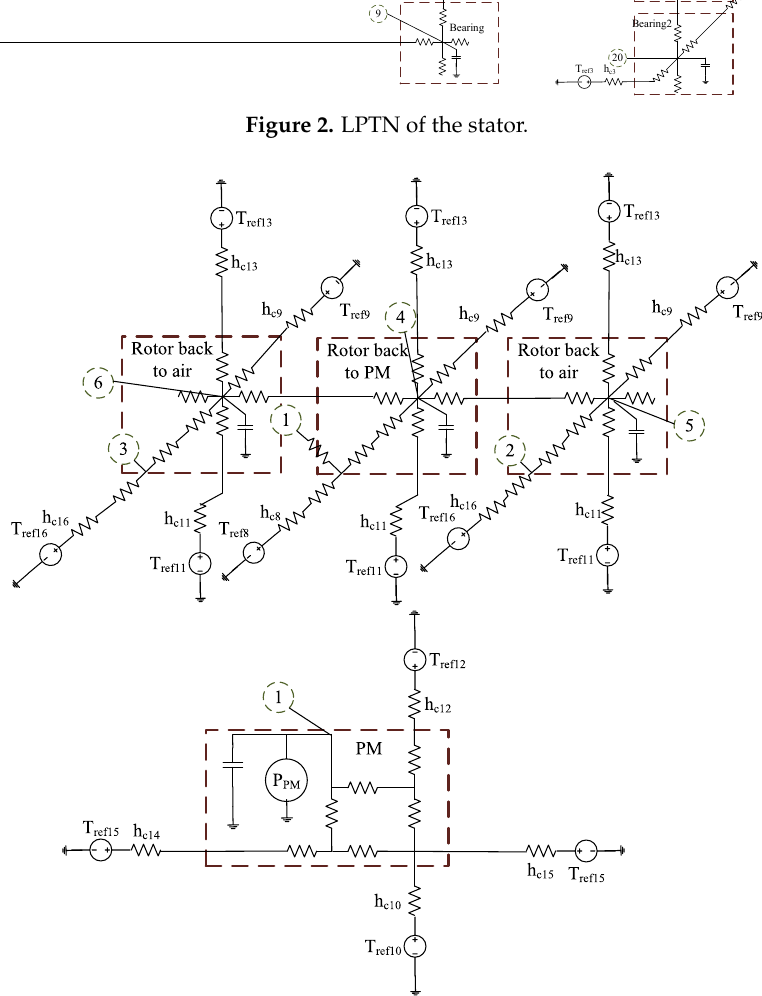
Figure 3. LPTN of the